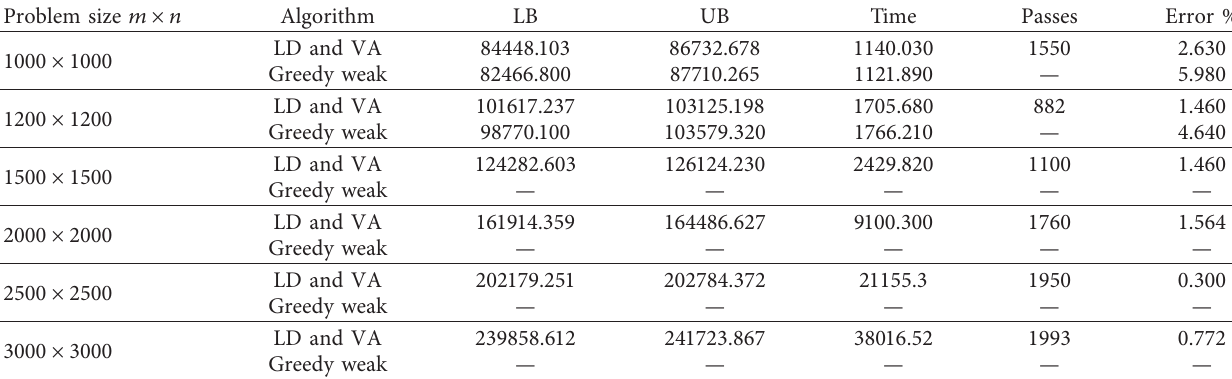
Table 3: Computational results of the LD and VA for the large problems sized